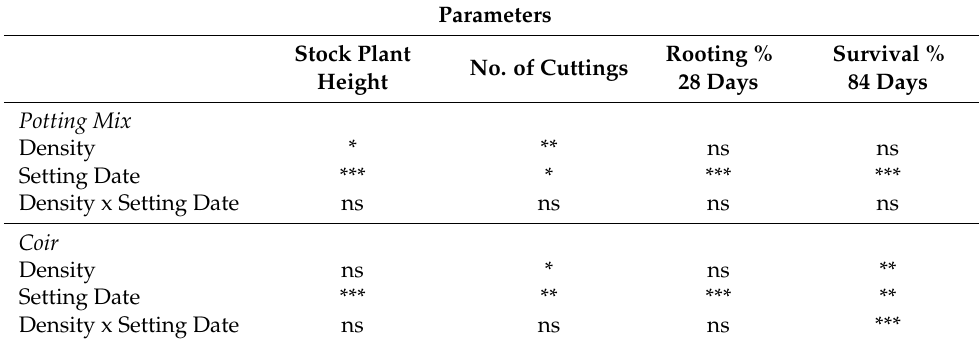
Table 2. Significance of main and interaction effects in a 2-way ANOVA for media type.